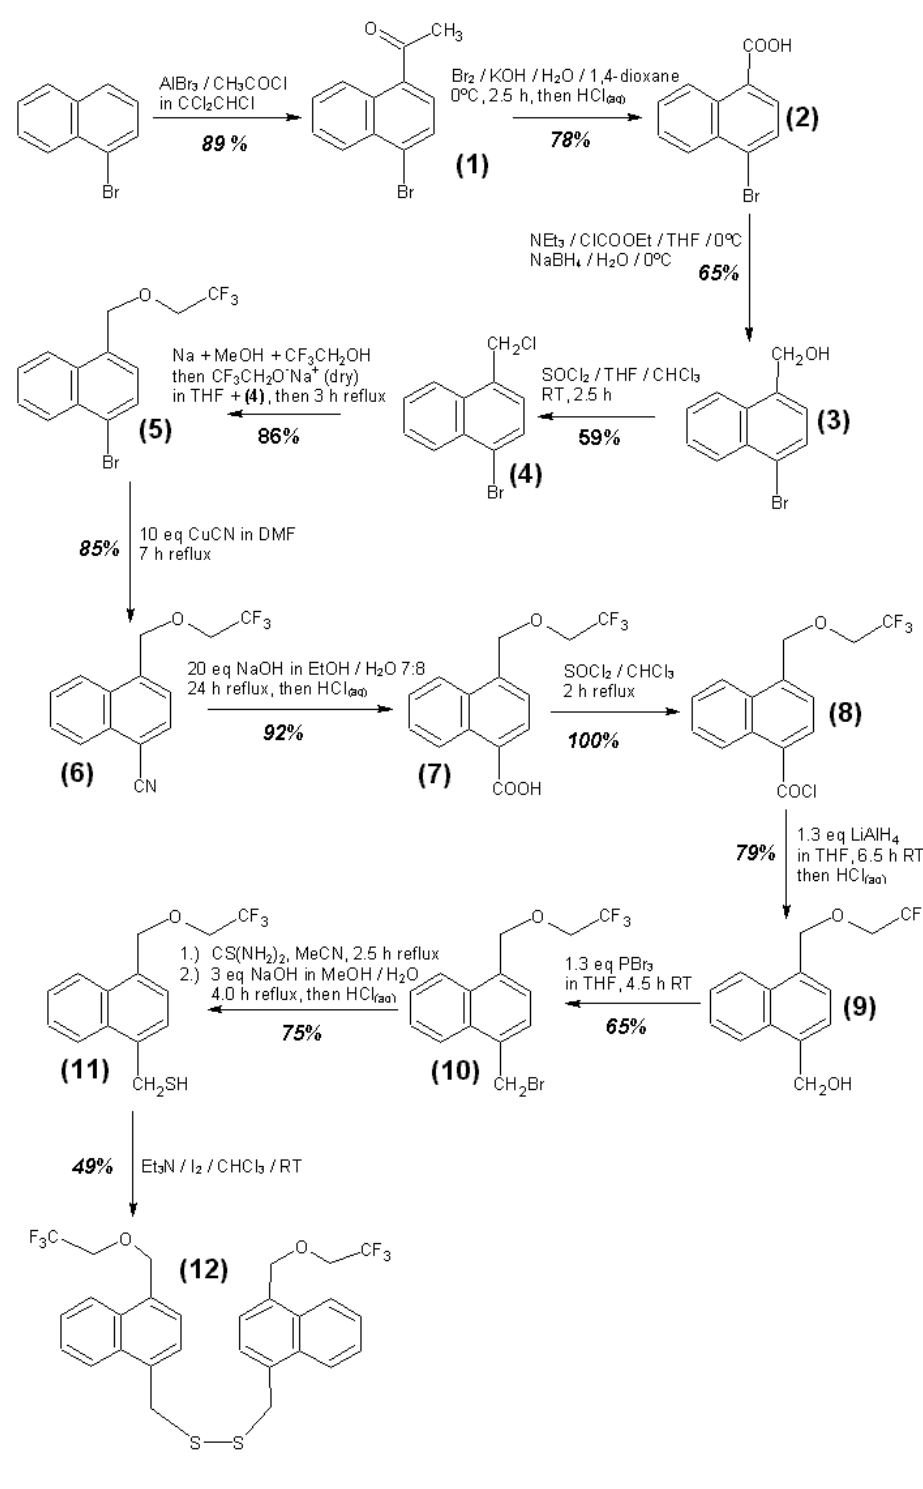
Figure 16. Synthesis steps for substances 1 to